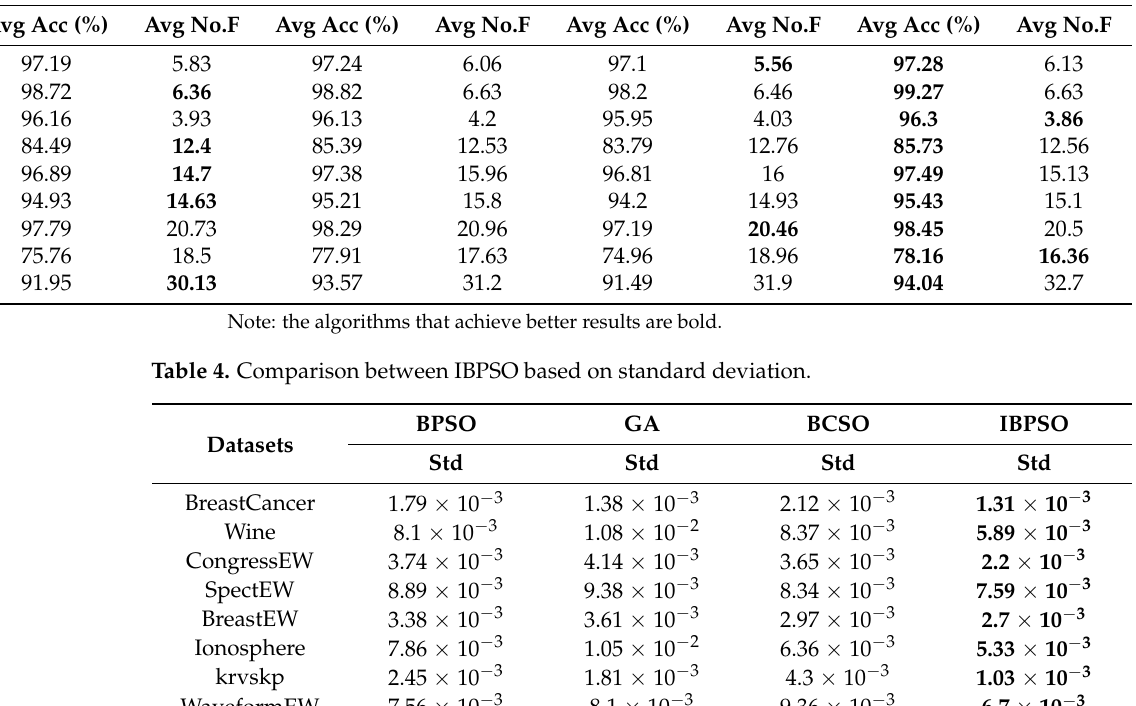
Table 3. Comparison between IBPSO based on classification accuracy and selected features in this experiment. Datasets